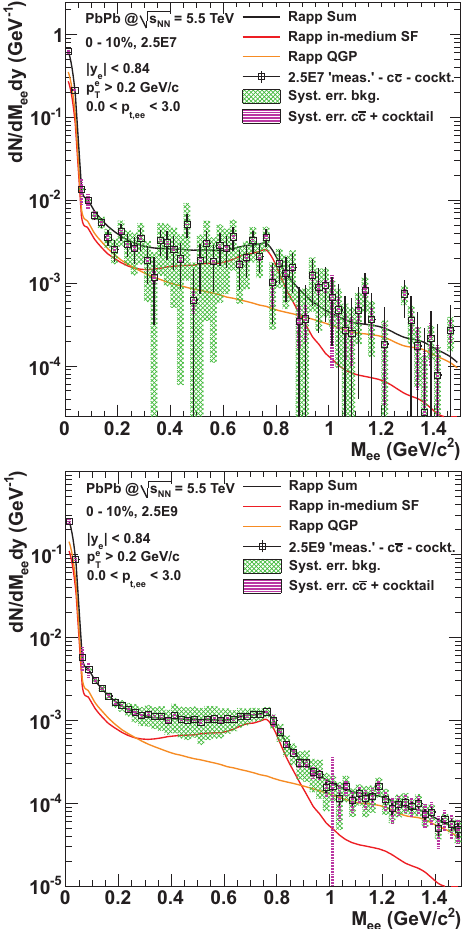
Figure 7. Improved performance of low-mass di-electron mea- surements without (top) and with (bottom) the upgraded ALICE, after subtracting hadron (cocktail) and charm contributions. The data points have been calculated using a model calculations with hadronic and QGP phase contributions with a realistic space-time evolution, including medium-modified spectral functions[5,